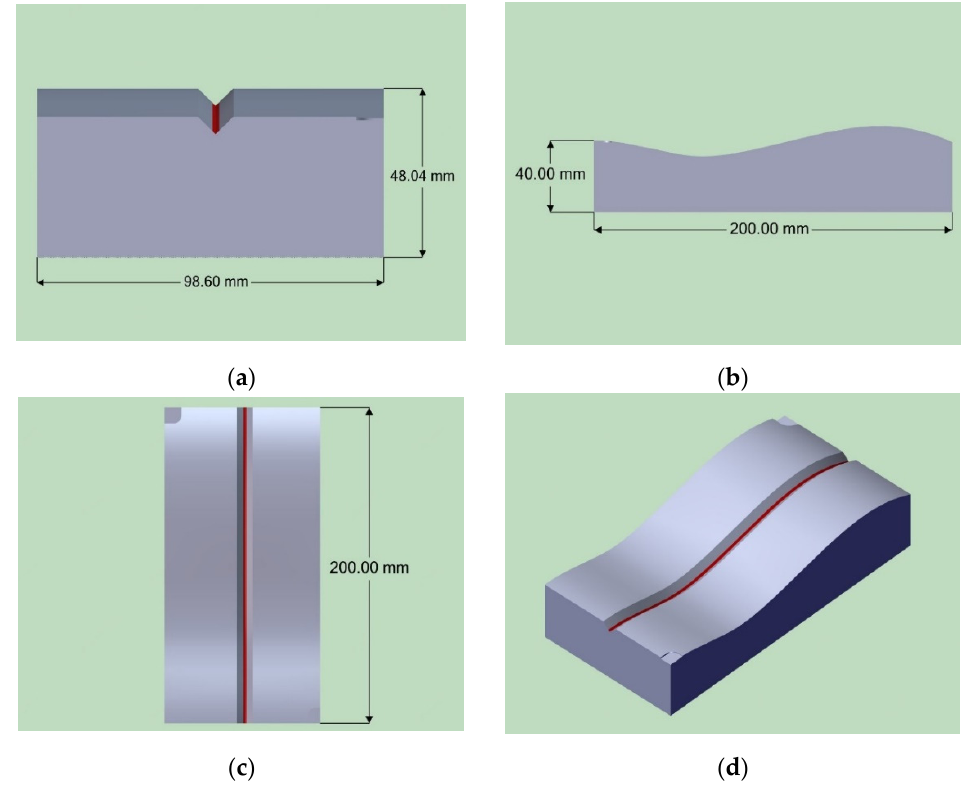
Figure 4. The model of the curved V-type butt joint with a red marker: ( a ) front view; ( b ) right view; ( c ) top view; ( d ) isometric view.